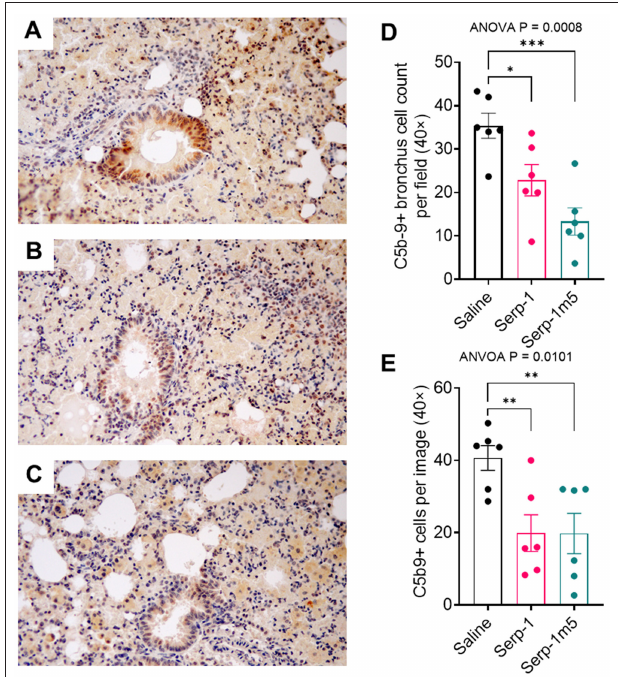
FIGURE 8 | C5b/9 staining is markedly increased in the bronchial epithelium and in the surrounding lung parenchyma in saline treated mice with pristane induced DAH (A) . Serp-1 (B) and Serp-1m5 (C) significantly detected reduced bronchial staining. Bar graphs demonstrate significant changes in the mean cell counts ± SEM for cells positively stained for C5b/9 in the bronchial epithelium (D) and in the lung parenchyma (E) ; Bronchus cell counts— p = 0.0008 ANOVA; Parenchyma ANOVA— p = 0.0101. * p < 0.05, ** p < 0.01, *** p <